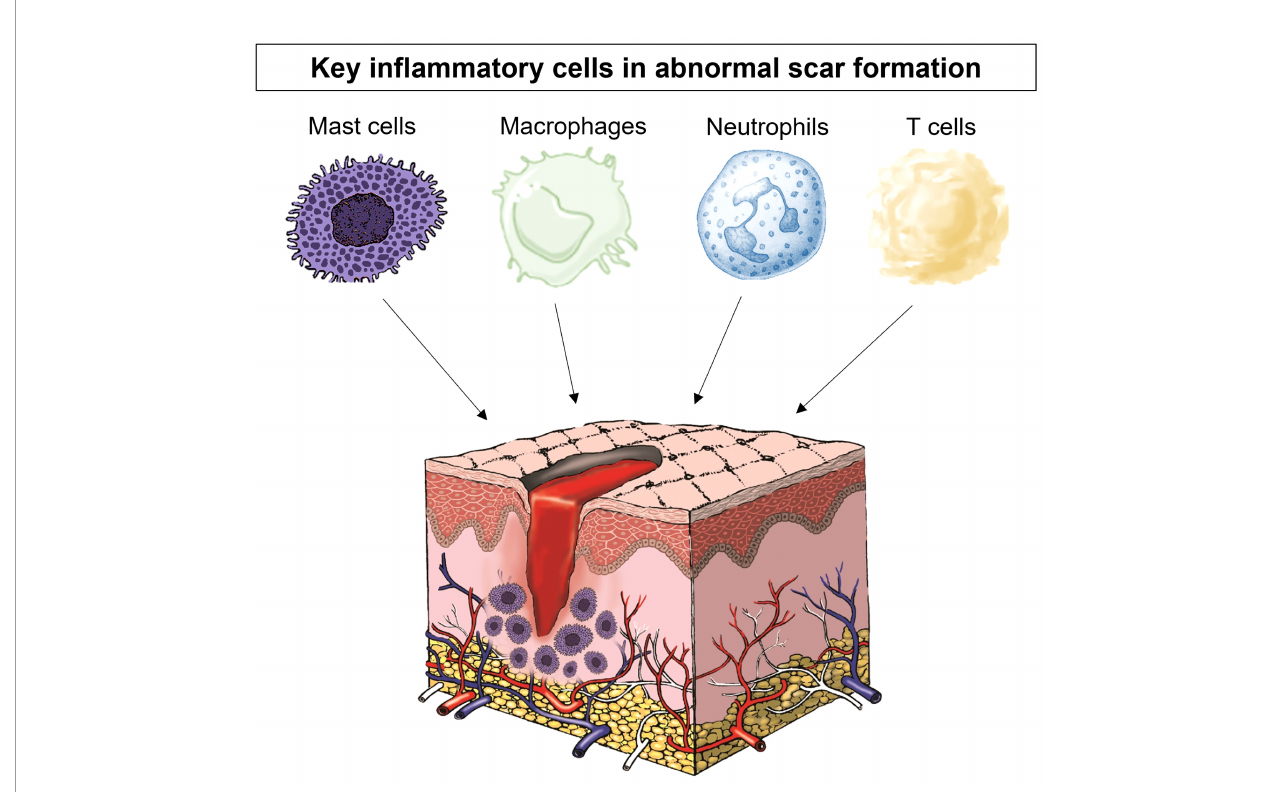
FIGURE 1 | The key in fl ammatory cells in scar formation include mast cells, macrophages, neutrophils and T